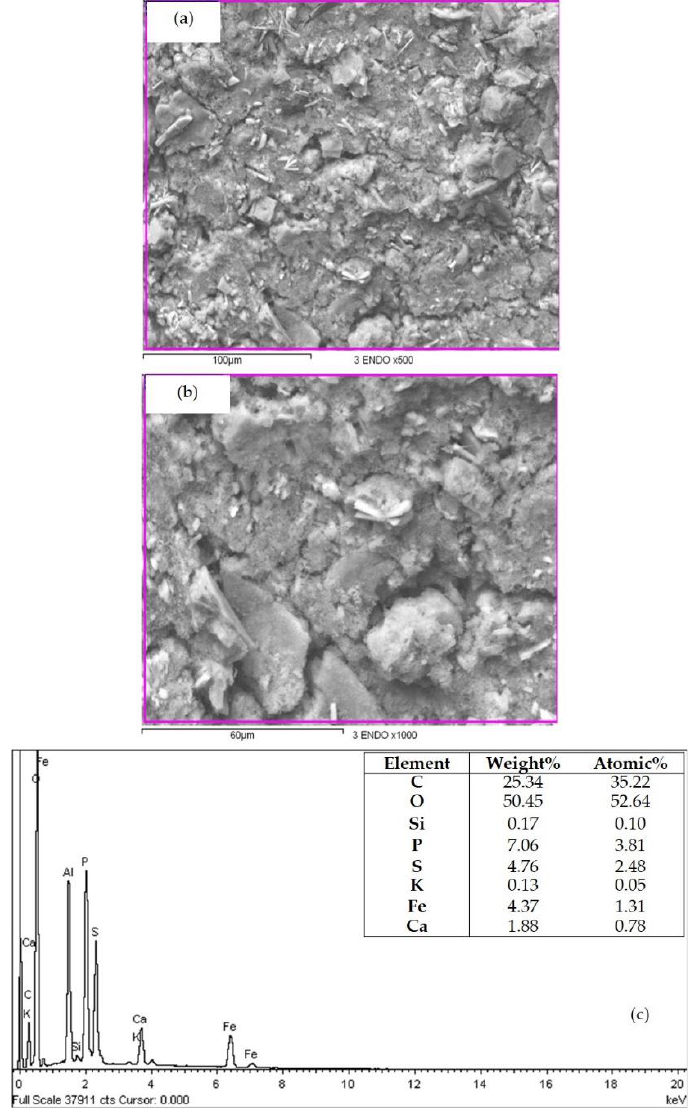
Figure 3. SEM micrographs of the CMSP powder extracted from Chaetoceros muelleri . Images are at 500× ( a ) and 1000× ( b ) magnification. Element composition of the CMSP, analyzed by EDX ( c ).